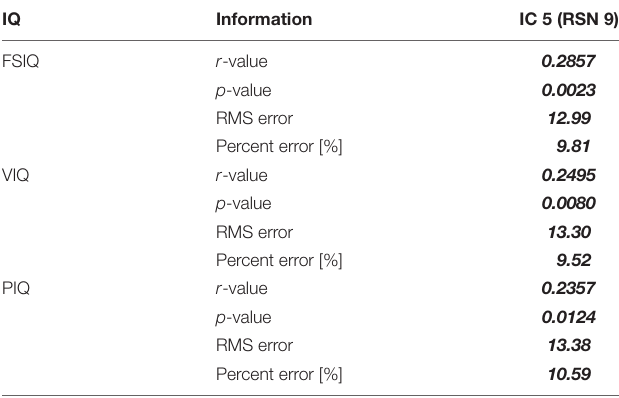
TABLE 5 | Prediction of IQ scores using degree values of the identified